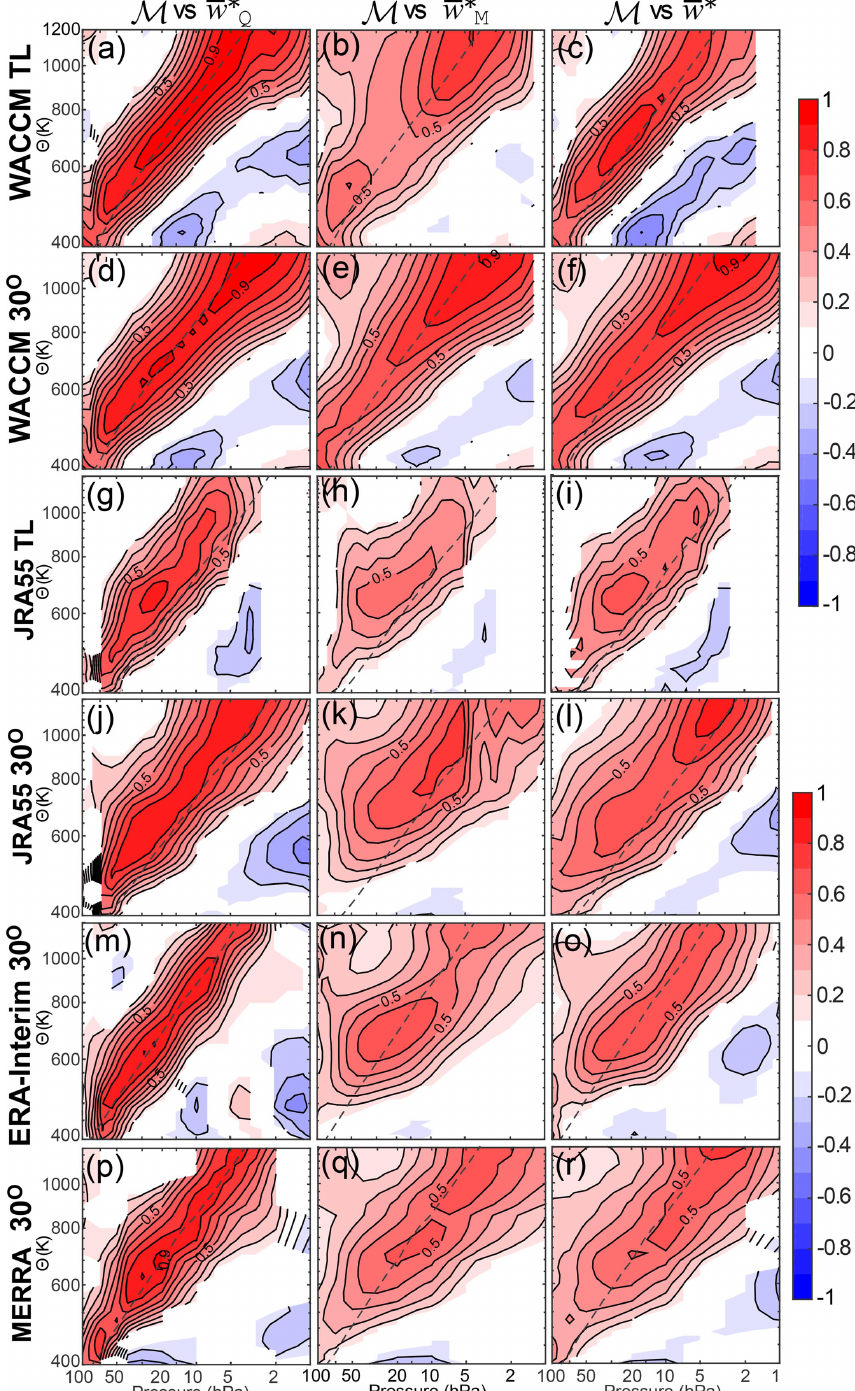
Figure 6. The correlation of three different estimates of the TEM vertical velocity with the global diabatic circulation M . (a–c) WACCM model with TEM vertical velocities averaged between the true turnaround latitudes; (d–f) WACCM model with fixed 30 ◦ S–30 ◦ N tropical averaging latitudes; (g–i) JRA-55 reanalysis averaged between turnaround latitudes; (j–l) JRA-55 averaged between fixed 30 ◦ S–30 ◦ N; (m– o) ERA-Interim averaged between fixed 30 ◦ S–30 ◦ N; (p–r) MERRA averaged between fixed 30 ◦ S–30 ◦ N. The first column is the correlation of the global diabatic circulation with ¯ w ∗ ; the second column is the correlation of the global diabatic circulation with ¯ w ∗ ; the third column M Q is the correlation of the global diabatic circulation with ¯ w ∗ . The gray dashed line shows the climatological relationship between pressure and potential temperature averaged between 20 ◦ S and 20 ◦ N. Contours spaced every